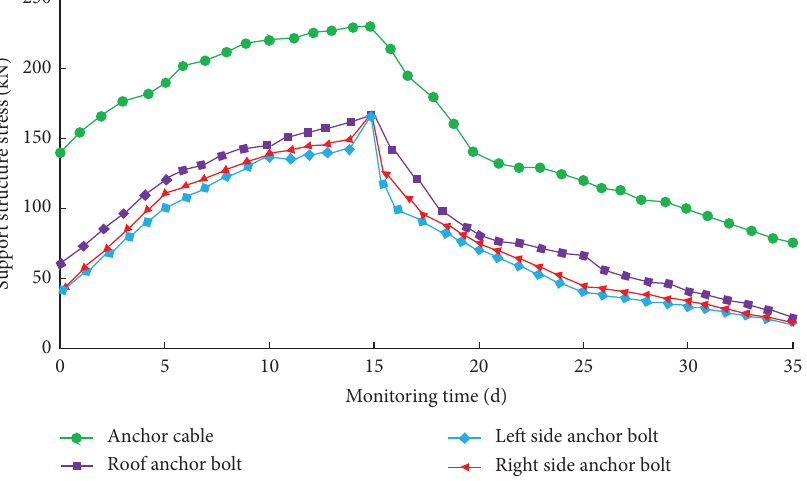
Figure 2: Stress monitoring curve of support structure.